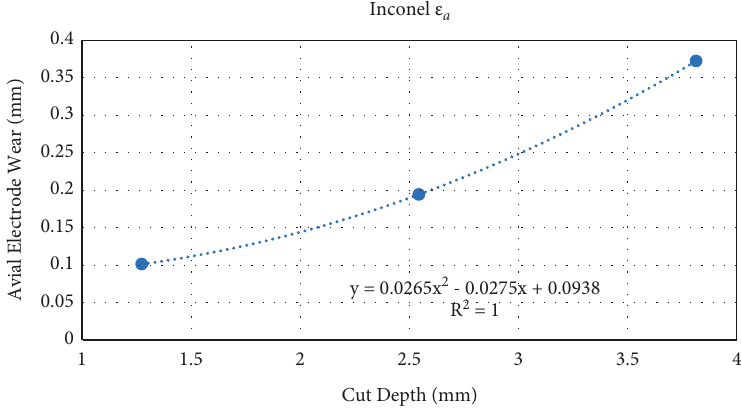
Figure 12: Mean ε a due to cut depth in